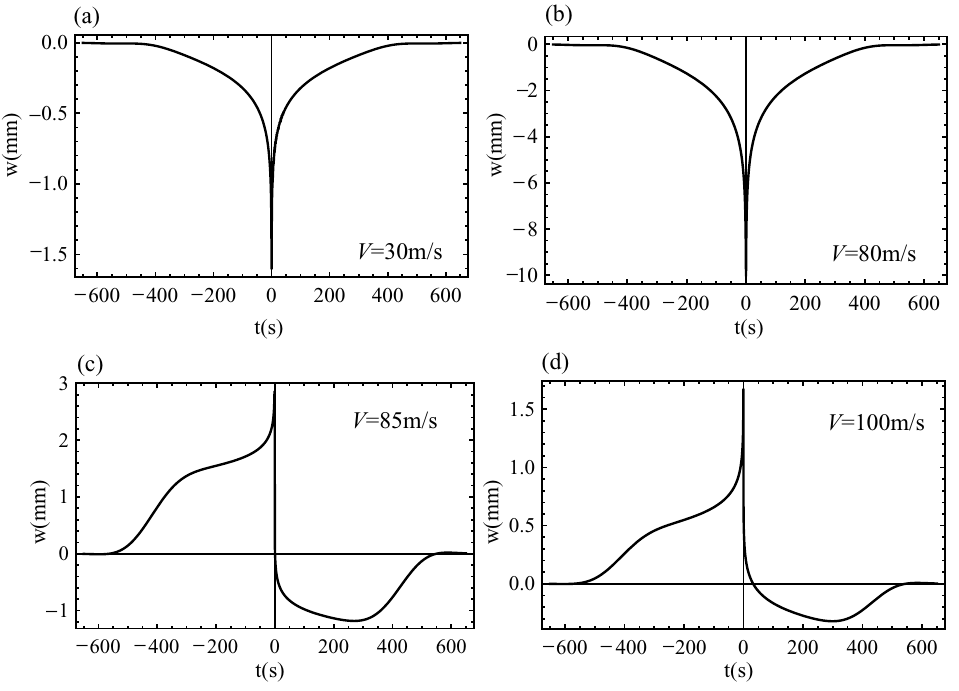
Fig. 9. The vertical displacement for the velocity: (a) V = 30 m/s, (b) V = 80 m/s, (c) V = 85 m/s, (d) V = 100 m/s. higher than but close to 82 m/s, in Figs 8c and 9c. The amplitude of displacements decreases when the load moves with a velocity above the critical value V cr and the shapes of plots do not show further significant changes (Figs 8d and